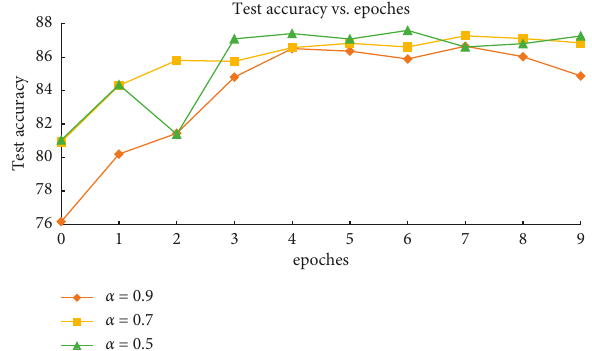
Figure 5: Parameter sensitivity